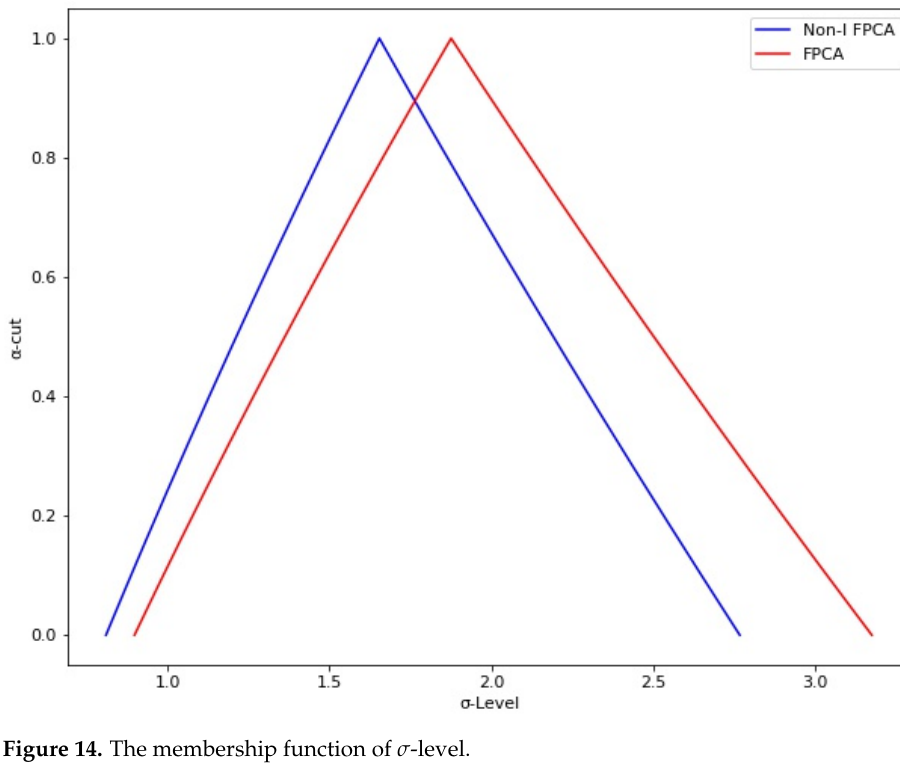
Figure 13. The membership function of 𝑃(cid:3560) (cid:3043)(cid:3038)(cid:3030) .